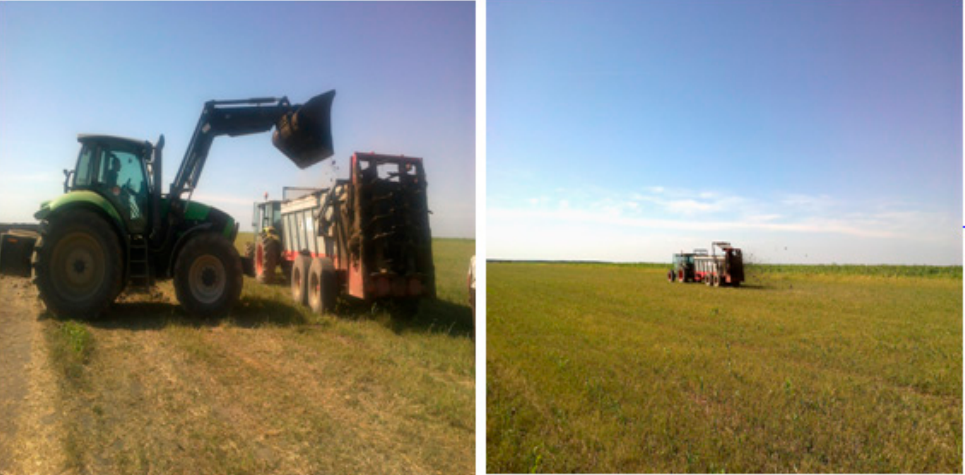
Figure 5. Loading the Manure spreading machine (MIG) with urban sewage sludge and spreading it. tivated sewage sludge basin (sequential biological reactors).